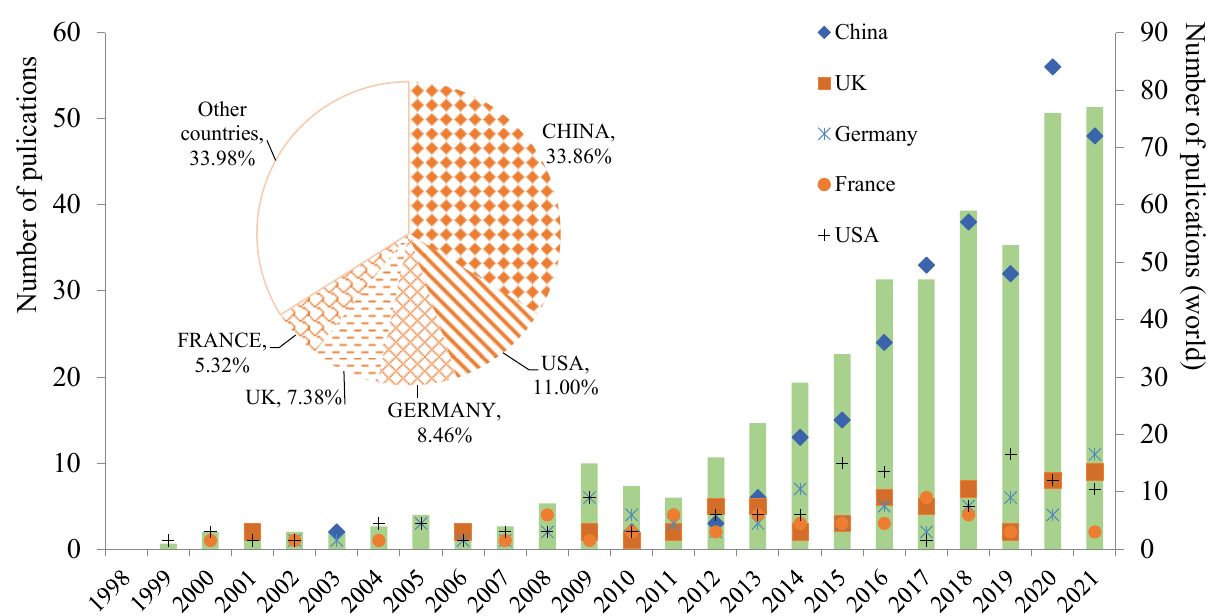
Figure 2. Timeline and percentages of publications in producing countries.